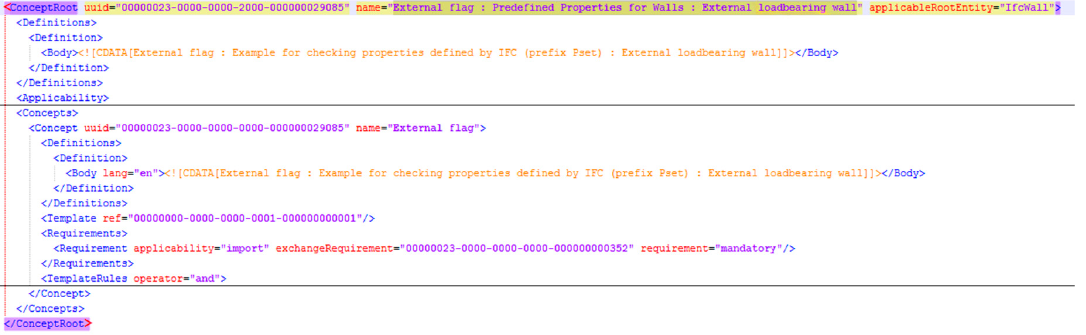
Figure 6. MvdXML snippet. Appl. Sci. 2019 , 9 , x